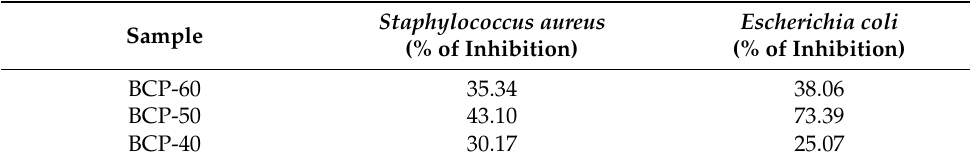
Table 2. Percentage of inhibition of bacterial